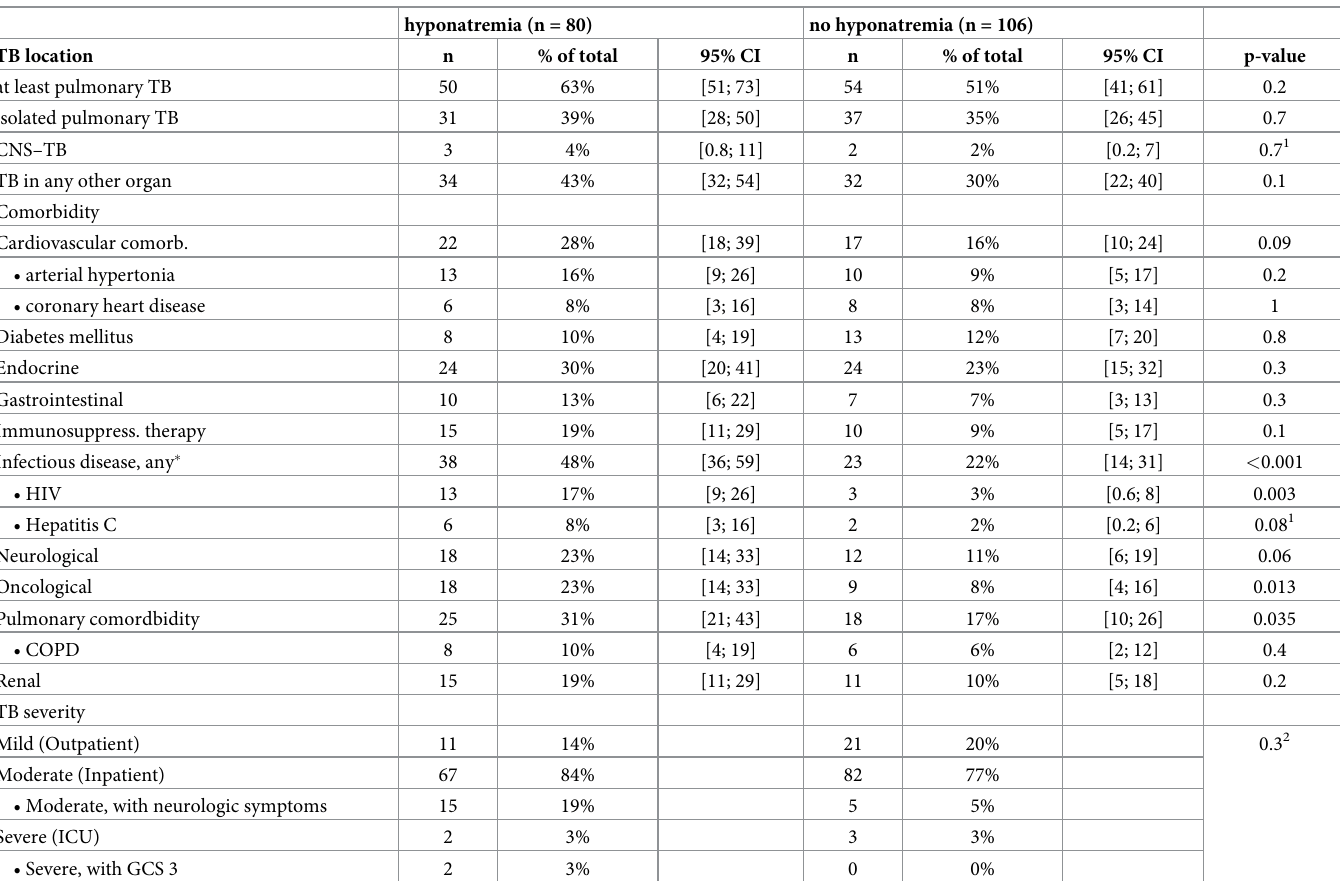
Table 1. Characteristics of TB in patients grouped by hyponatremia. Patients with TB and hyponatremia had more frequent infectious, pulmonary, malignant and car- diovascular comorbidities. When we analysed the cardiovascular comorbidities in-depth, neither arterial hypertonia nor coronary heart disease was associated with increased hyponatremia. TB severity was not associated with hyponatremia. Group comparison is shown with absolute frequencies (n), percentages with 95% CI, and unadjusted p-values (Chi-squared tests, if not stated otherwise). Note that the interpretation of the p-values is descriptive. TB, tuberculosis. CNS, central nervous system. COPD, chronic obstructive pulmonary disease. HIV, human immunodeficiency virus infection. ICU, intensive care unit. GCS, Glasgow Coma Scale.